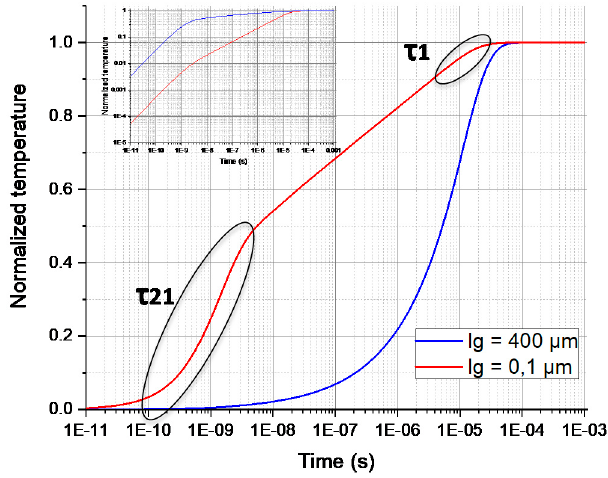
Figure 10. Normalized temperature response versus time (inset log (Temperature) vs. log (time)).